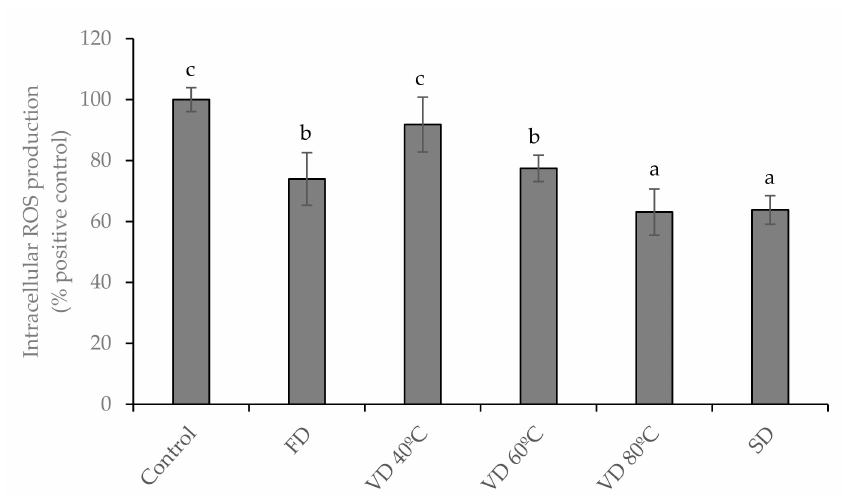
Figure 2. Protective e ff ect of PEP (1 mg / mL) on intracellular ROS production. HT-29 cells were incubated with the powders for 24 h and then treated with 2.5 mM TBHP for 3 h, and ROS production was determined. Values are expressed as a percentage relative to the control conditions and are represented by mean ± SD ( n = 3). Bars with di ff erent letters indicate significant di ff erences on ROS production by ANOVA post hoc LSD Tukey test ( p ≤ 0.05). Freeze drying (FD); Vacuum drying 40 ◦